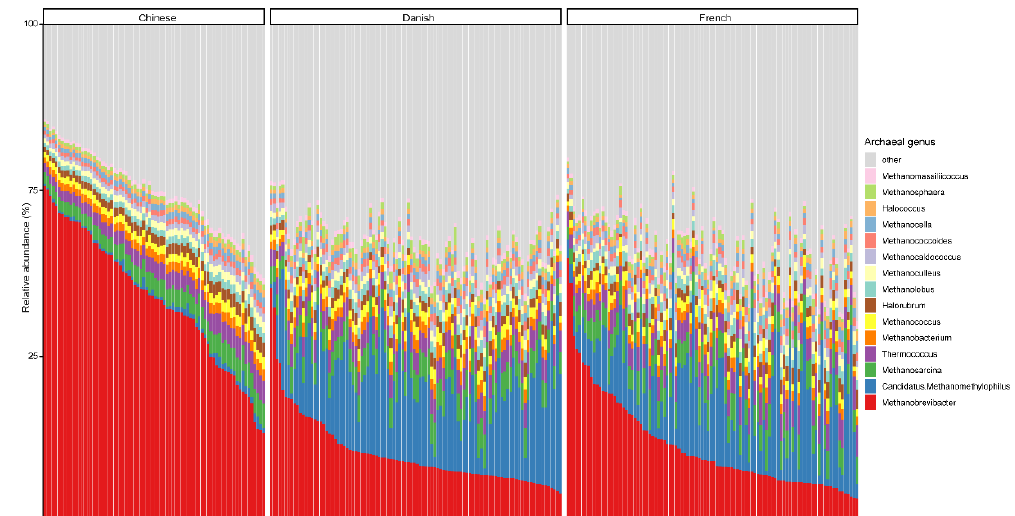
Figure 2. Relative abundance of the top 15 archaeal genera in swine fecal samples from different countries. Each column represents one pig, and each color represents one archaeal genus. The y -axis represents relative abundance ranging from 0 to 100%.